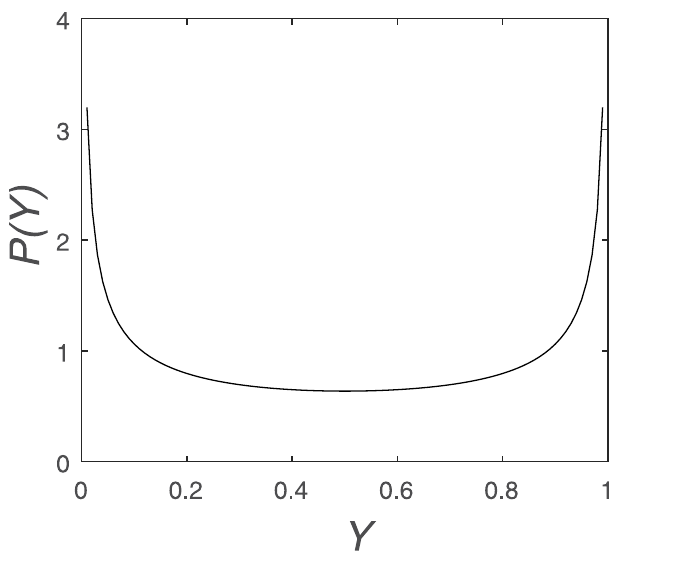
Fig 5. Probability distribution function of the logistic map with A = 4.